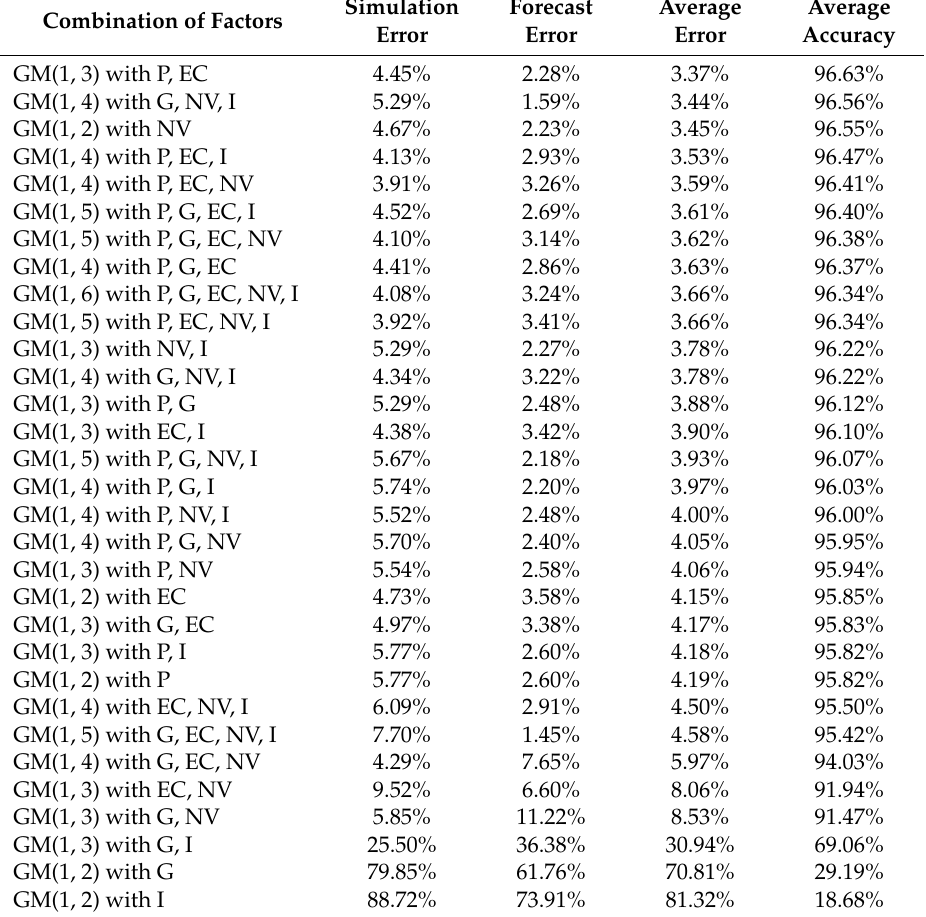
Table 4. Mean error and accuracy rate of Taiwan CO 2 emission amount GM(1, N ) model.